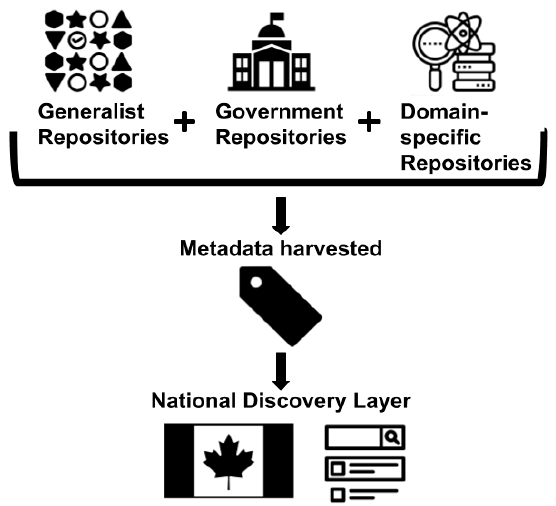
Figure 1. The Federated Research Data Repository (FRDR) harvests metadata from a variety of data repositories to create a national discovery layer for Canadian research data.